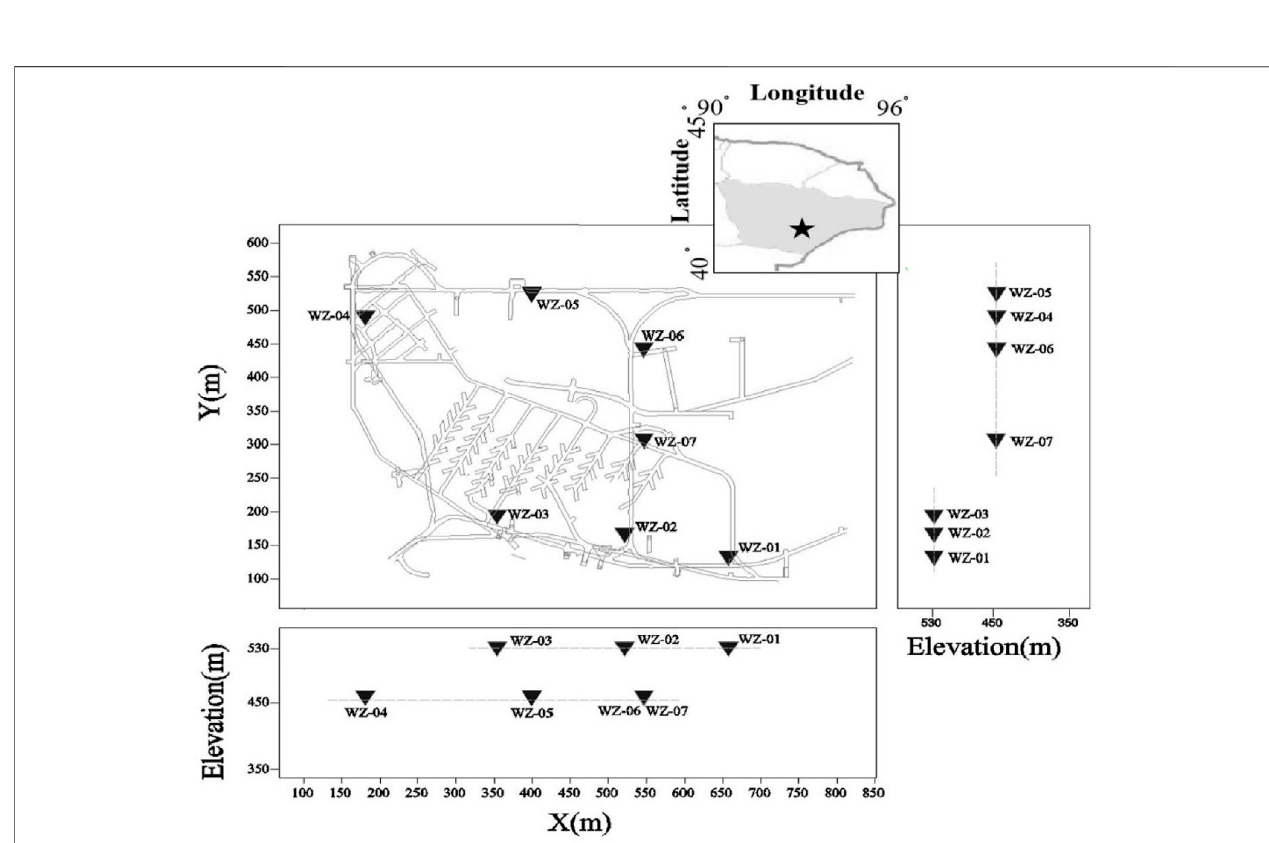
FIGURE6| Ametalminemicroseismic monitoring networkinXinjiang, China,shown inonehorizontal(XY) and twoverticaldepthsections (XZand ZY)views.Dark inverted triangles are triggered-based seismometers.